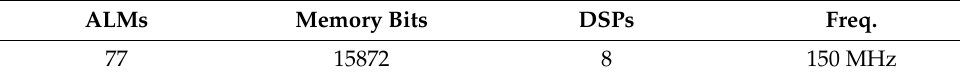
Table 3. Resources required by the SG IP and working frequency.